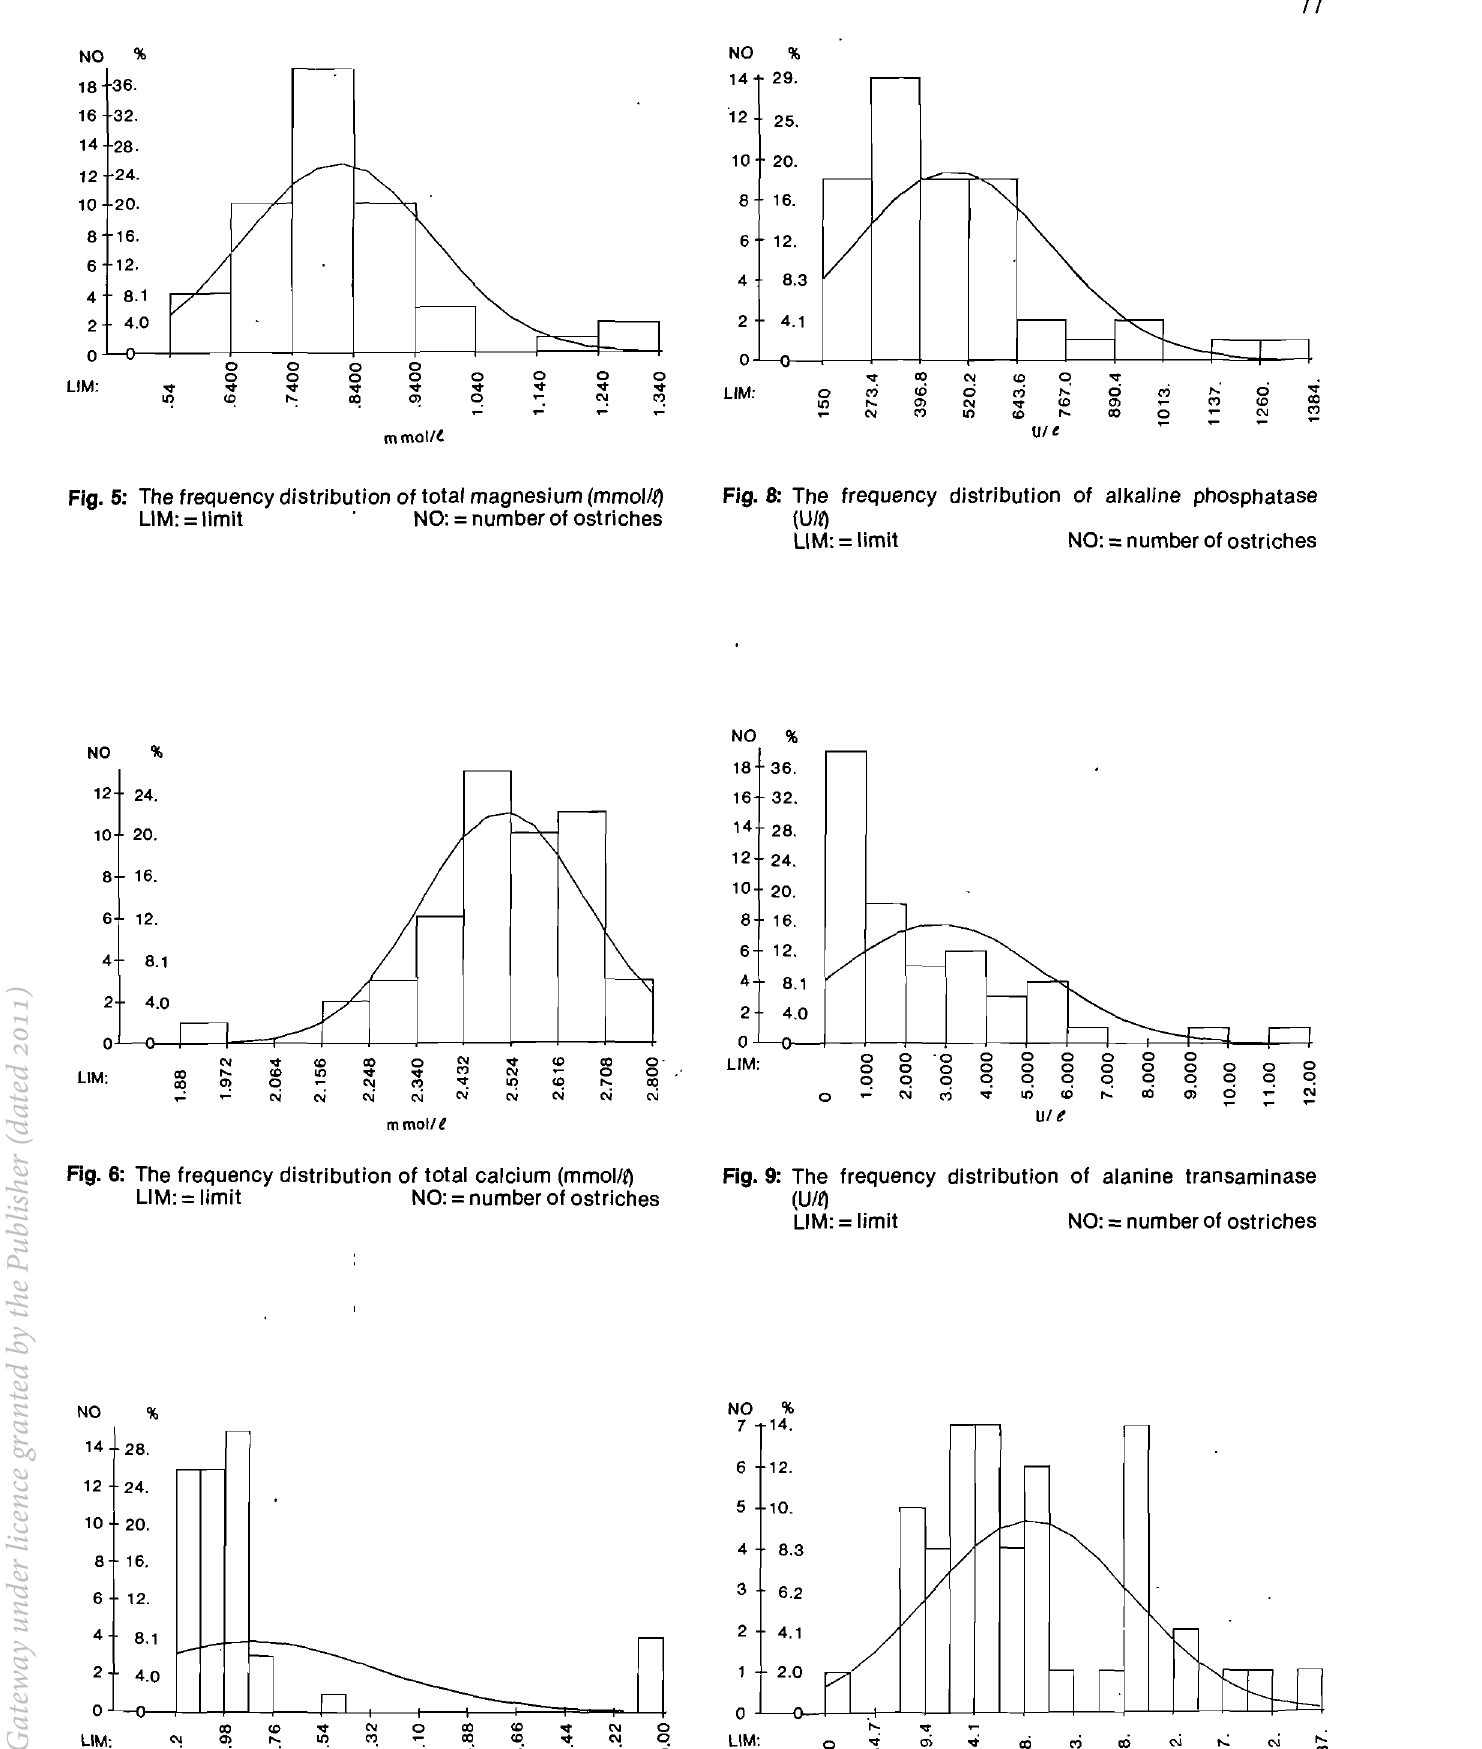
Fig. 10: The frequency distribution of lactate dehydrogenase (U/f) = LIM: limit NO: